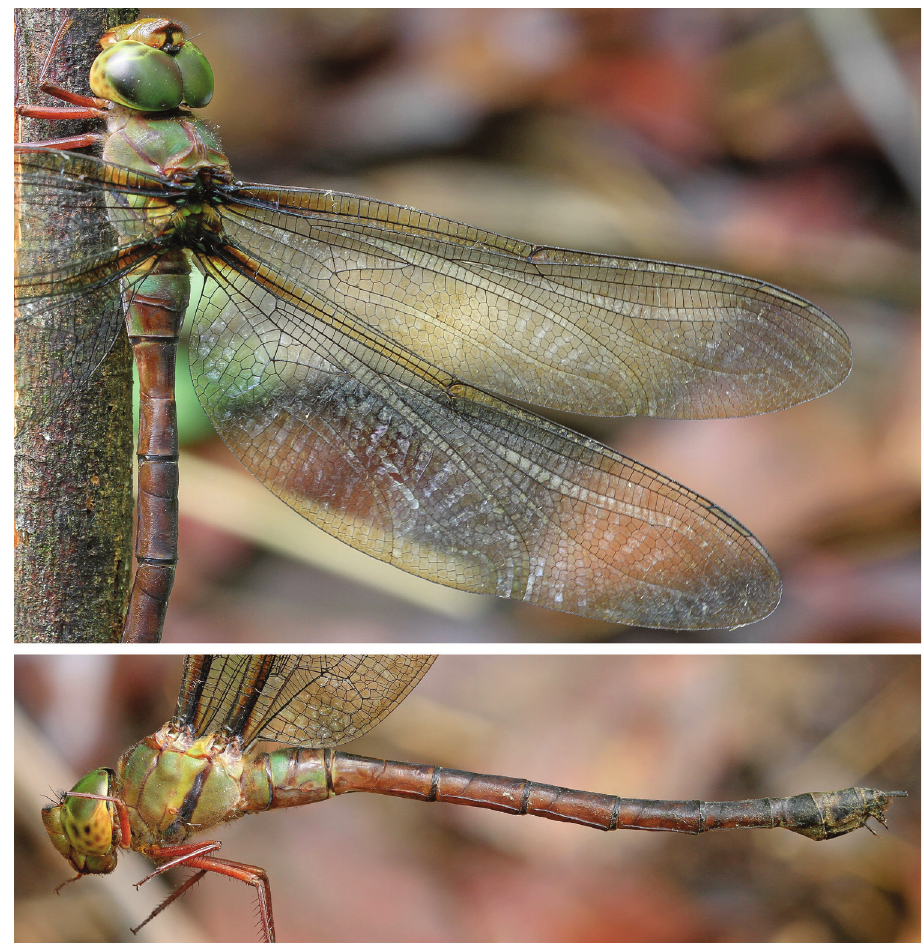
Figure 6. Heliaeschna fuliginosa , a female from the Mikwa Stream, near Chingombe, Zambia, with some recognisable diagnostic traits: the thoracic pattern, wing rays and wing venation (phot. B. Daraż). Fw and Hw follows the tendency noticed in Central African males in contrast to West African ones (Dijkstra